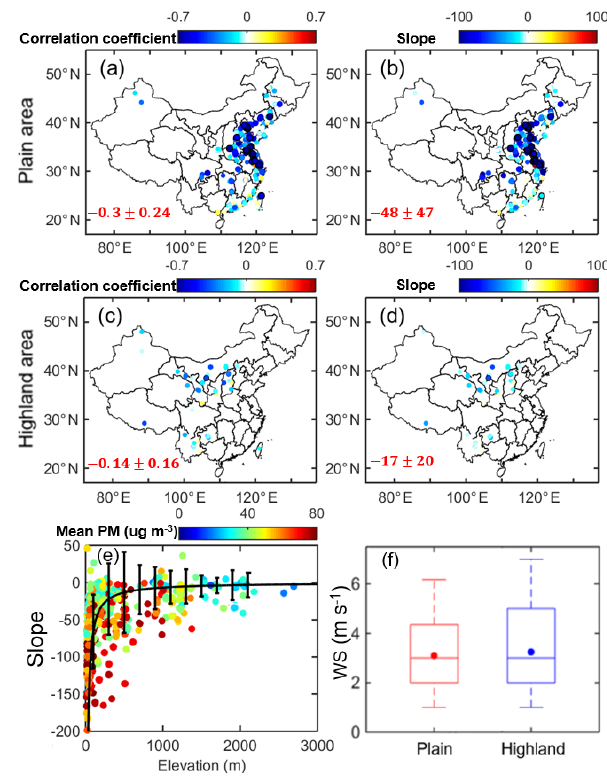
Figure 12. Stratification by terrain elevation. The correlation coeffi- cients ( R ) and slopes (unit: kmµgm − 3 ) between CALIPSO PBLH and PM 2 . 5 for the inverse fit ( f (x) = A/x + B ) are shown for the (a–b) plains and (c–d) highland areas. Note the slope in the inverse fit is defined as A . (e) The slopes of the inverse fit (i.e., and PM 2 . 5 ) under different station linear slopes between − 1 PBLH elevations, with color shading indicating station mean PM 2 . 5 con- centration. (f) Box-and-whisker plots showing the 10th, 25th, 50th, 75th, and 90th percentile values of the early-afternoon WS for plain and highland regions. The dots indicate the mean